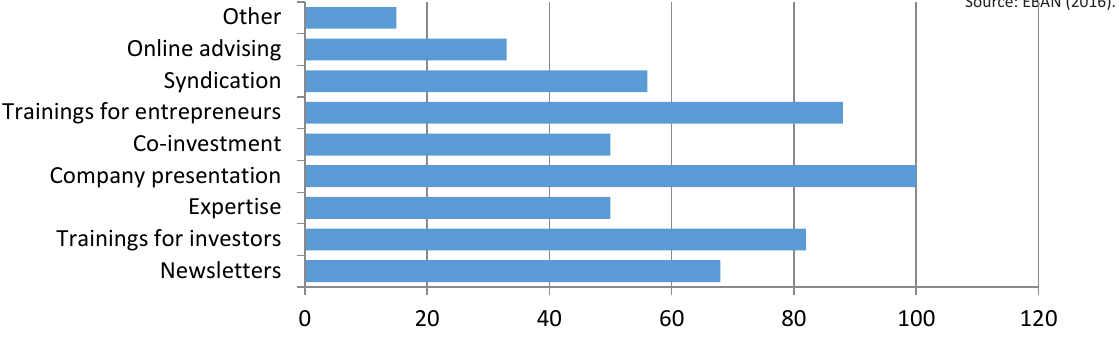
Figure 2. Distribution of services provided by EU business angels in 2016 (percentage of the total number of business angels), % Table 1. Comparative analysis of venture capitalists and business angels Characteristics